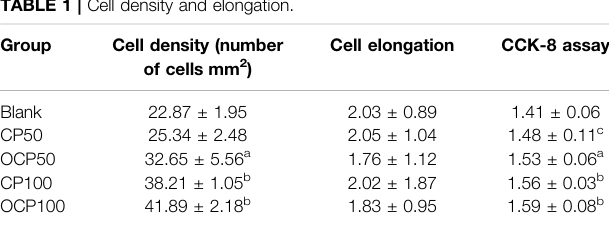
TABLE 1 | Cell density and